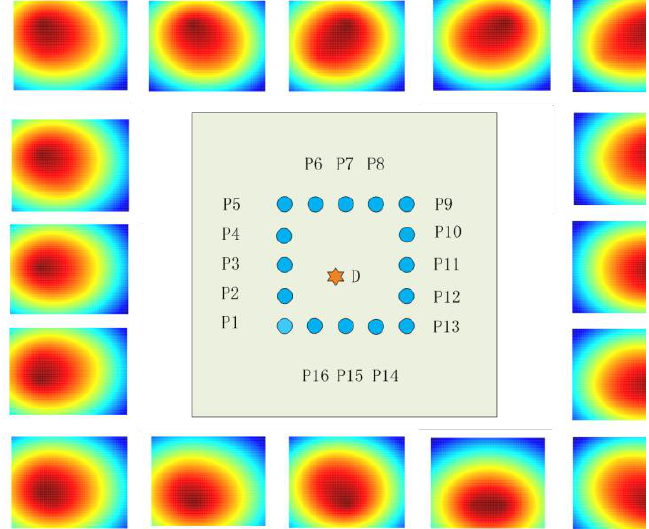
Figure 10. Sixteen tomography maps at each transducer array spot based on probabilistic reconstruction